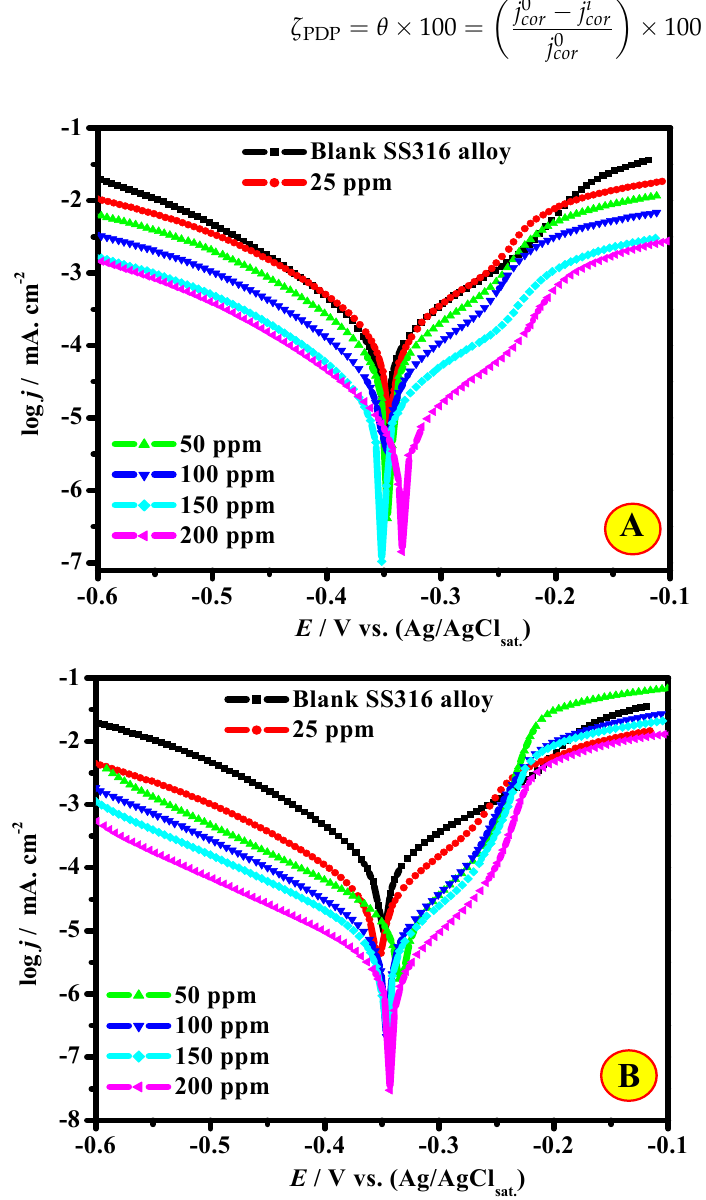
Figure 7. PDP plots of SS316 alloy in 2.0 M HCl solution with and without various concentrations of ( A ) CEL and ( B ) NCC at 50 °C.